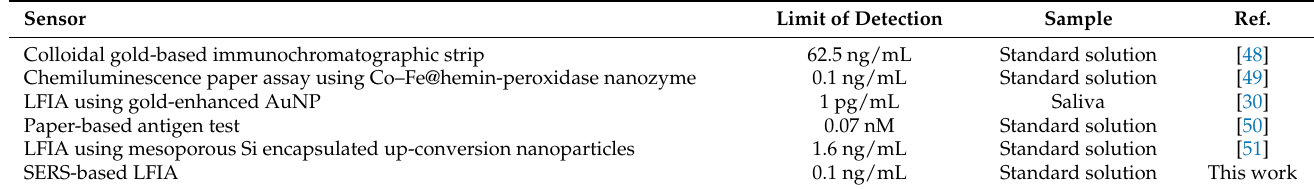
Table 1. Comparison of different SERS detection strategies for SARS-CoV-2 spike RBD